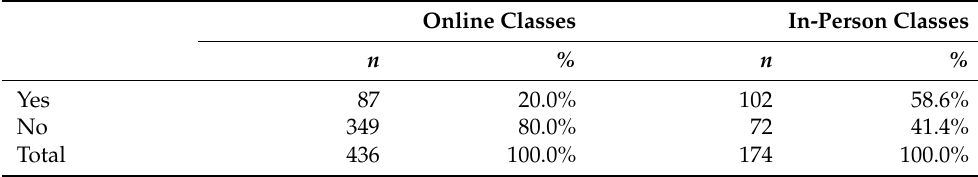
Table 11. Should instructors ban the use of digital devices during class? Online Classes